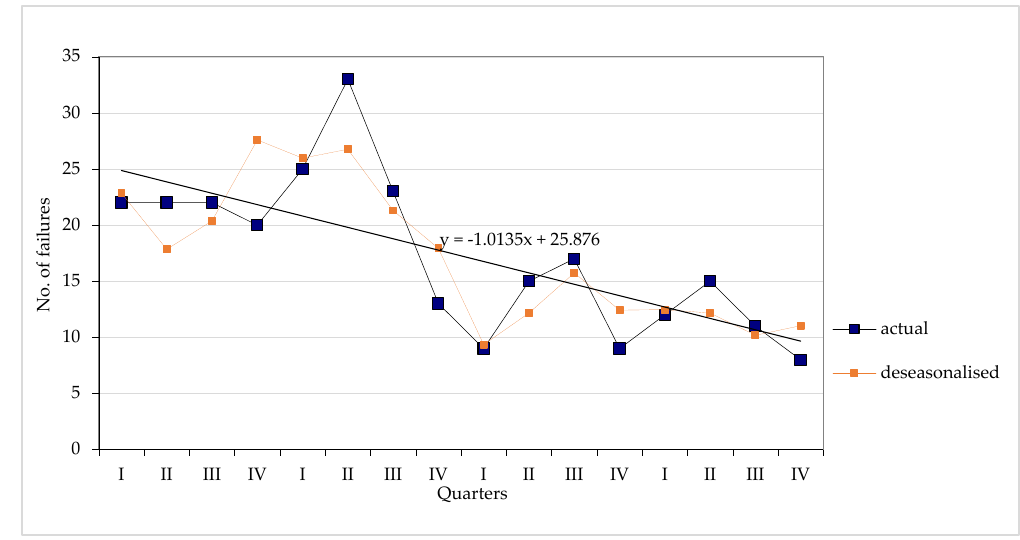
Figure 7. Actual and deseasonalised fluctuations in number of failures in the water network.